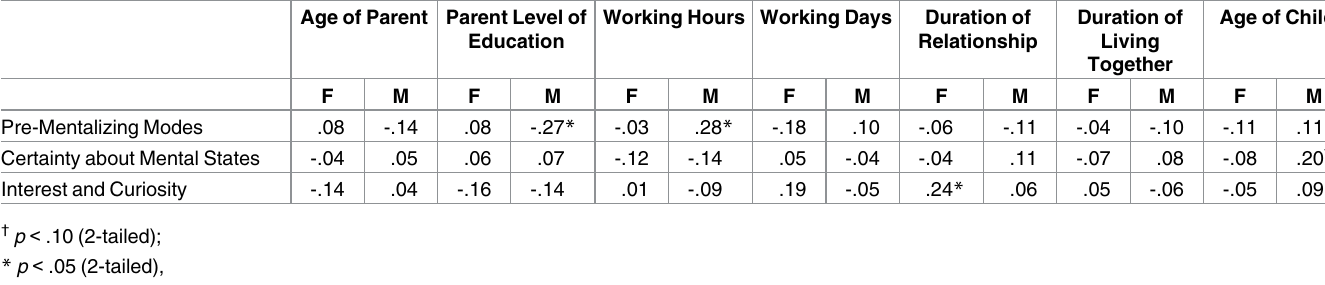
Table 6. Correlations among the PRFQ subscales and demographic featuresin Study 2 for fathers (F) and mothers